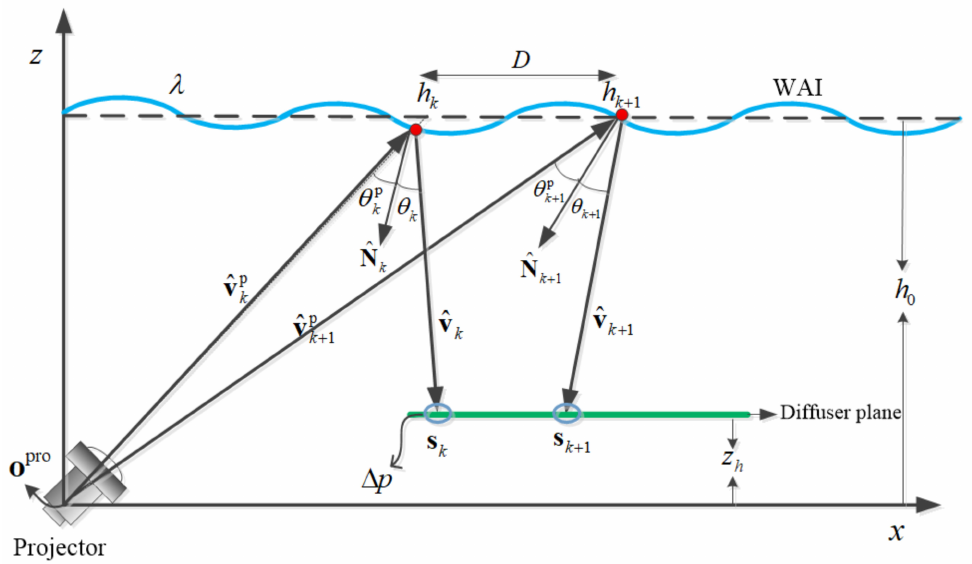
Figure 9. Geometry of the structured light projection system S